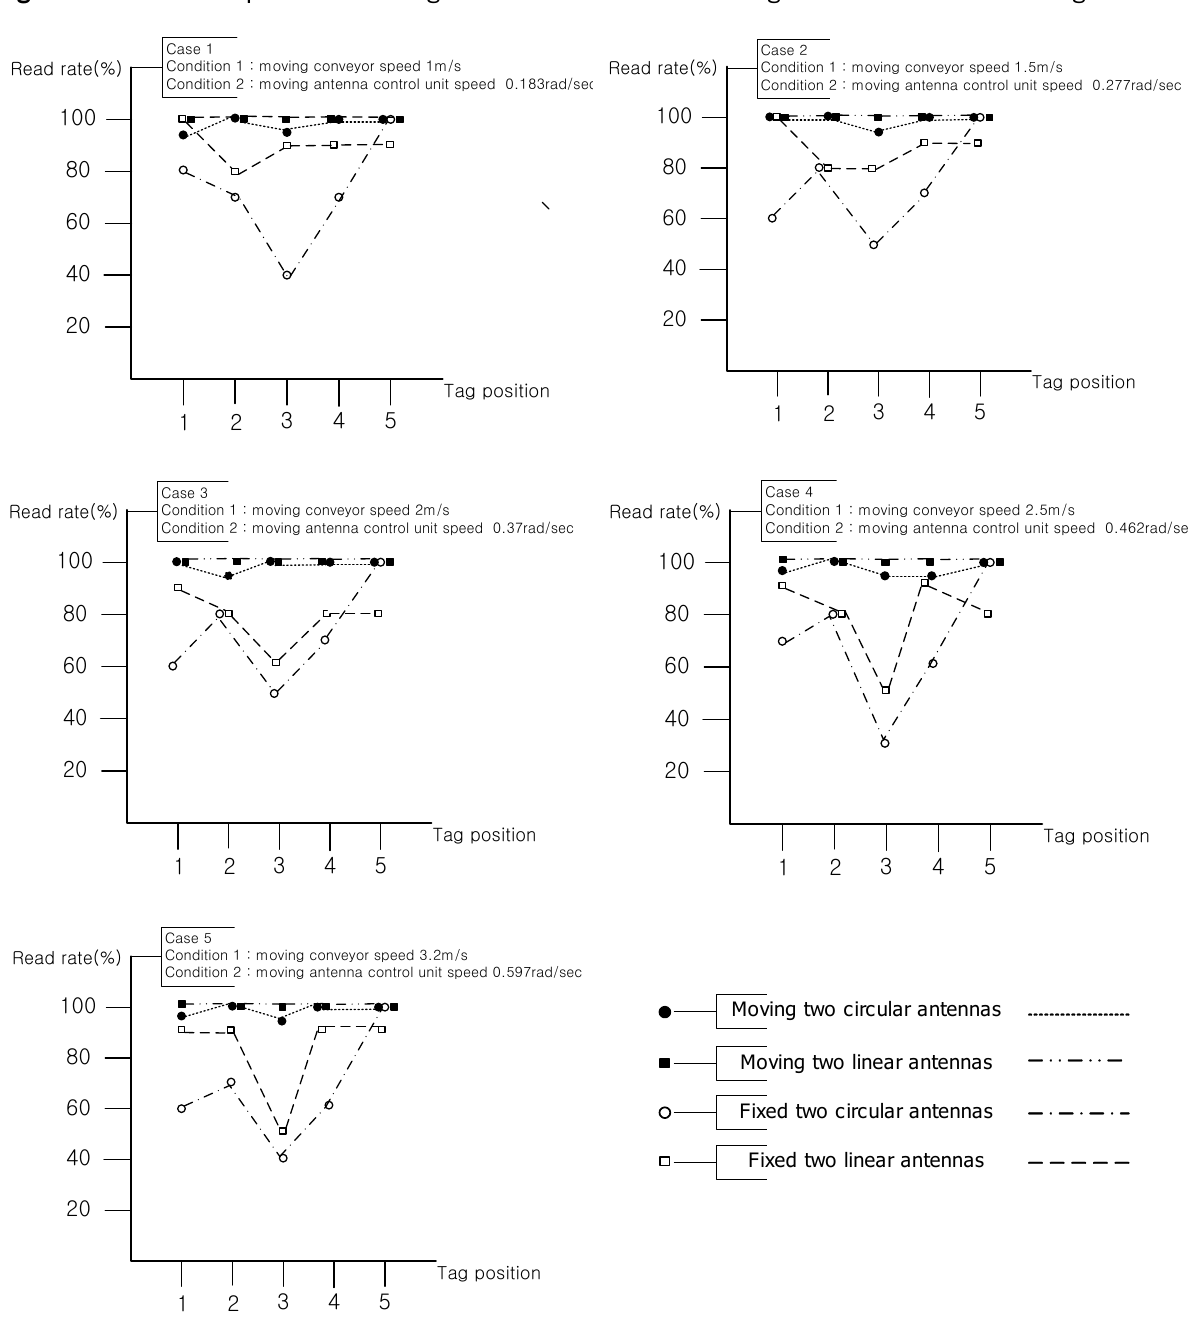
Figure 8. Direct comparison of recognition rates between moving and fixed antenna